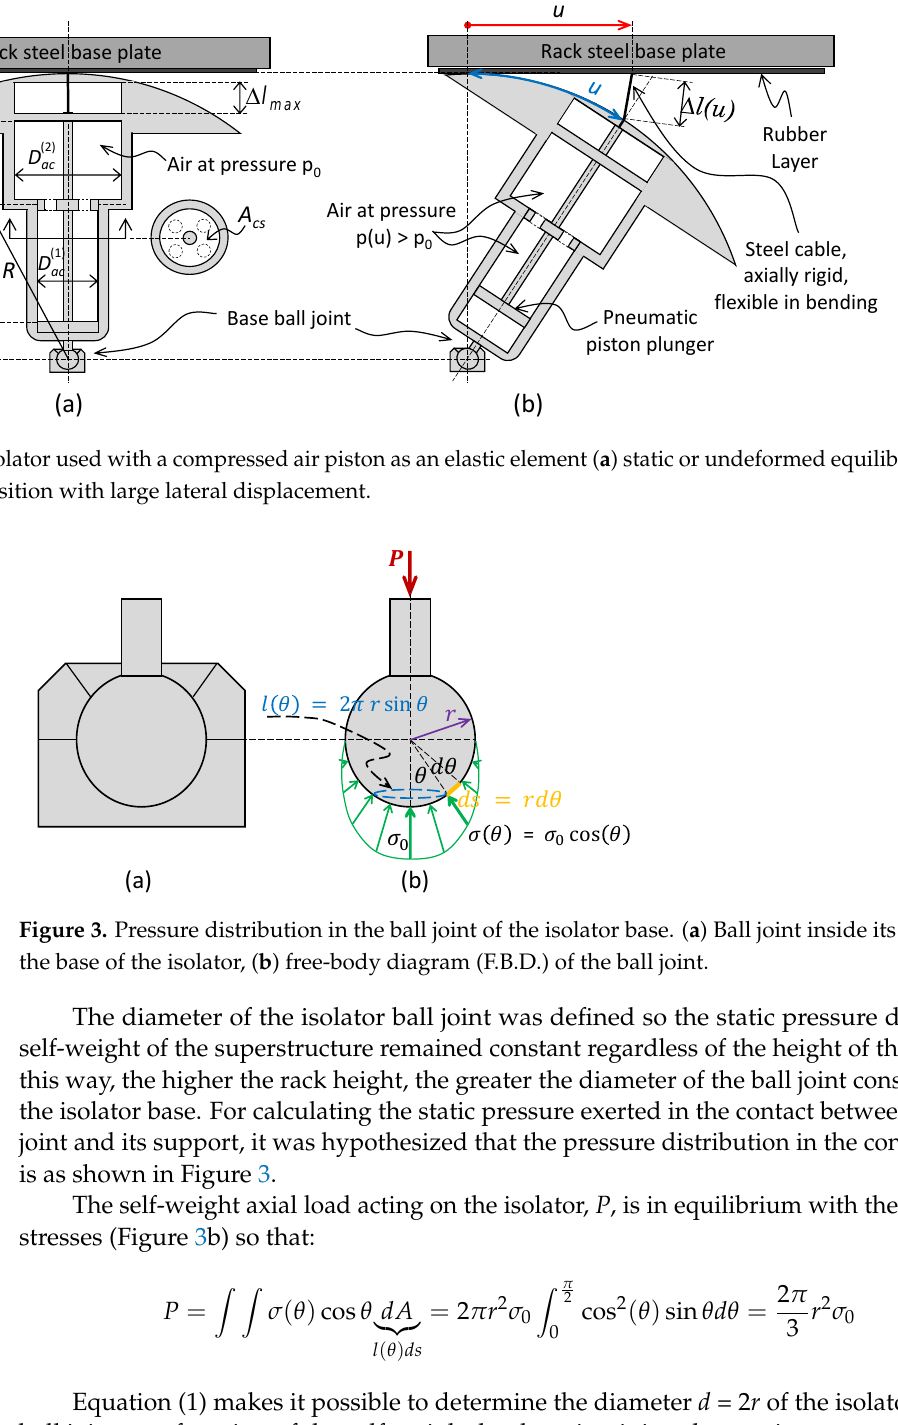
Figure 3. Pressure distribution in the ball joint of the isolator base. ( a ) Ball joint inside its bracket at the base of the isolator, ( b ) free-body diagram (F.B.D.) of the ball joint.